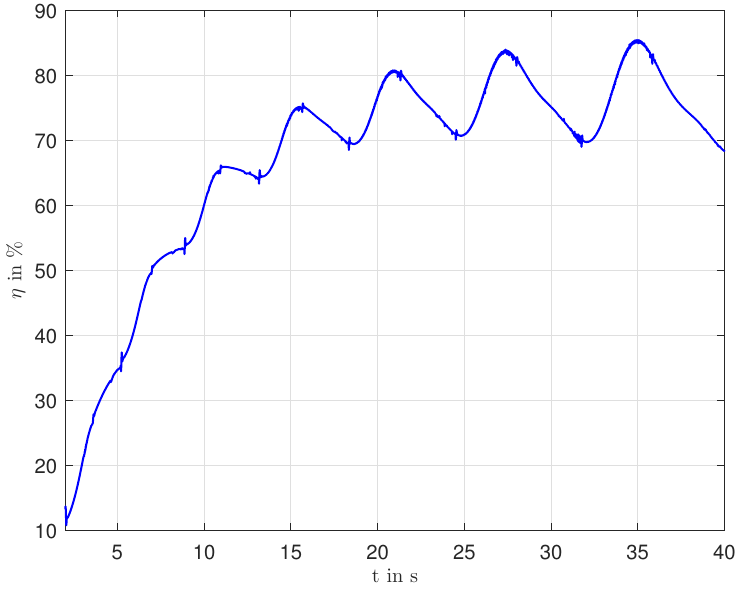
Figure 17. Dynamic efficiency of the IM during the traction